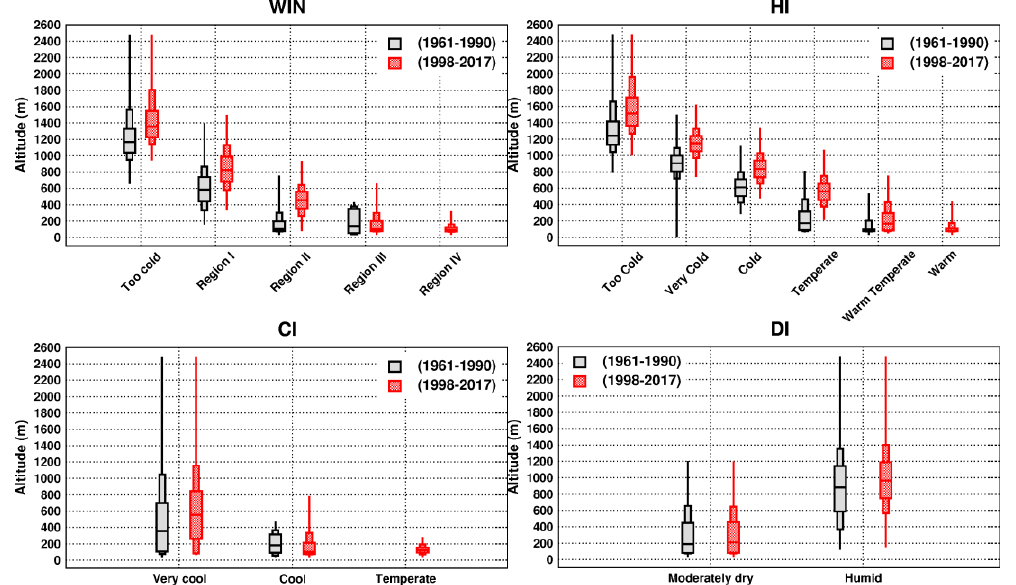
Figure 5. Quantiles of distribution of elevation in Winkler index (WIN), Huglin index (HI), Cool Nights index (CI), and Dryness index (DI) categories for periods 1961 – 1990 (black) and 1998 – 2017 (red). Whisker and box lines denote from bottom – up: minimum, 10th percentile, 25th percentile, median, 75th percentile, 90th percentile, and maximum anomaly.